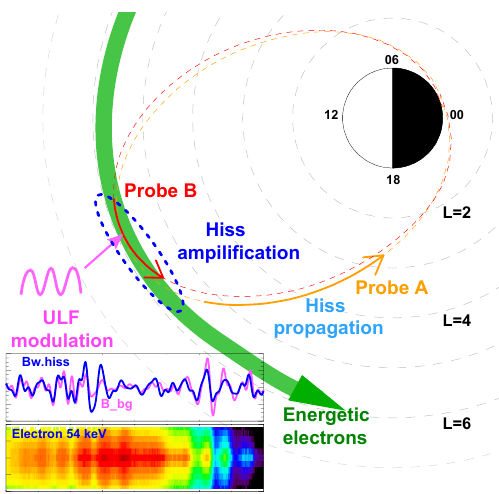
consistent with the energy of injected electrons. The hiss